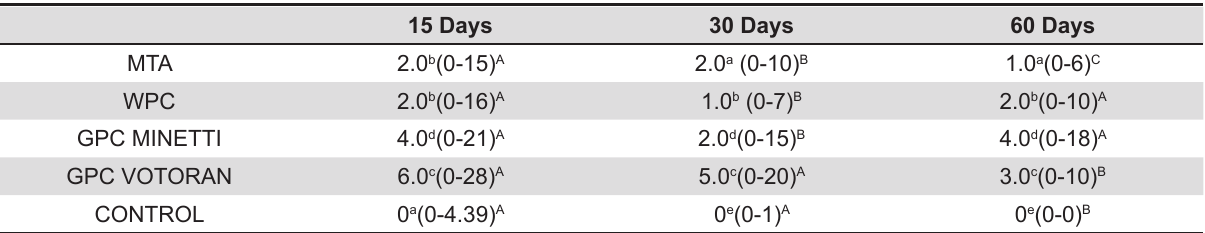
Table 1- Numerical density of inflammatory cells in the capsule adjacent to the empty tubes (control group) and to the tubes filled with cements